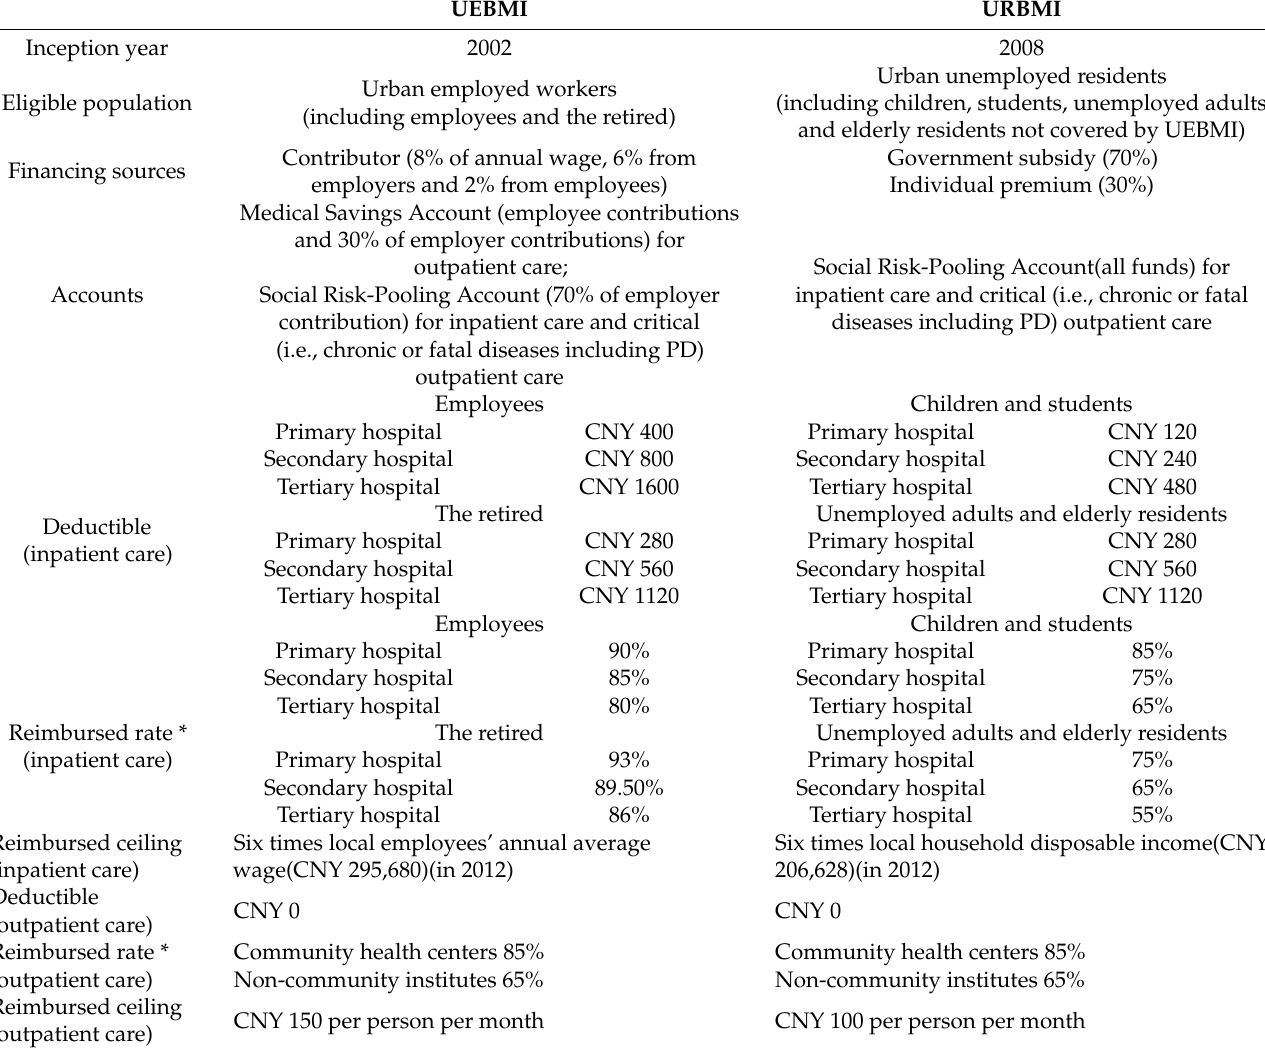
Table 1. Comparisons of UEBMI and URBMI policies for Parkinson’s disease in Guangzhou in